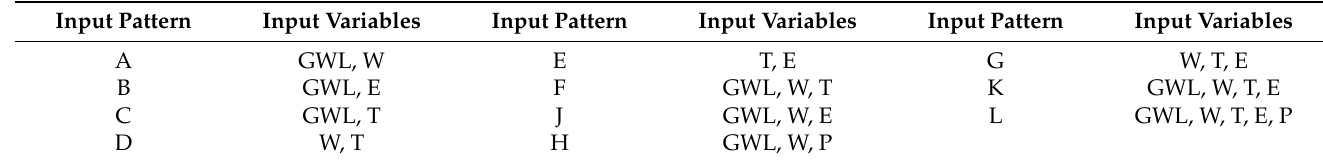
Figure 3. Thiessen polygons for observation wells and the location of P1 and P2 wells. Table 3. Input patterns for the prediction of GWL for observation well P1.